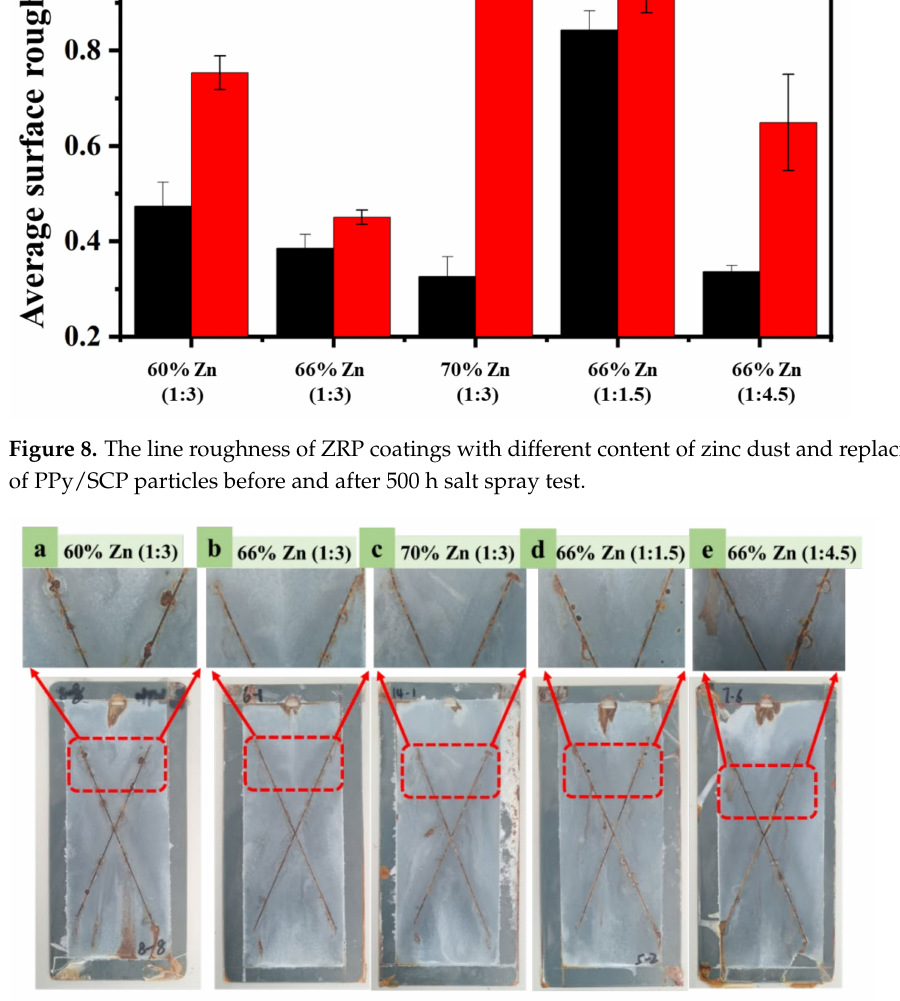
Figure 9. Surface appearance of zinc coatings after exposing to salt spray fog with 5% NaCl solution for 500 h: ( a ) 60% Zn (1:3); ( b ) 66% Zn (1:3); ( c ) 70% Zn (1:3); ( d ) 66% Zn (1:1.5); ( e ) 66% Zn